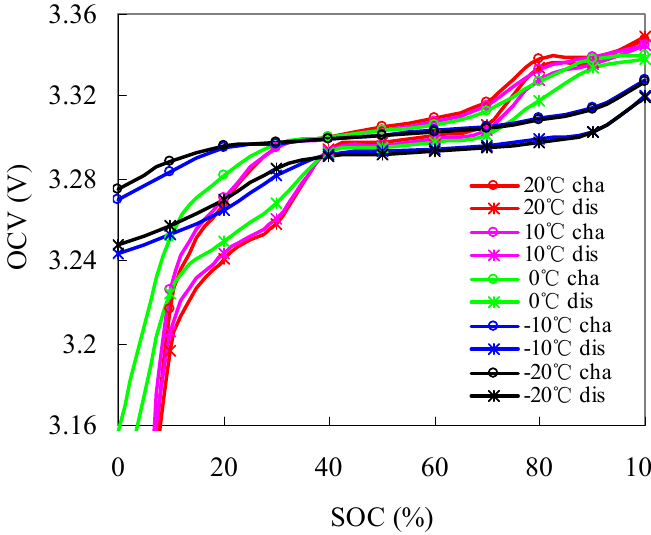
Figure 14. Charged and discharge R–L non-rated OCV–SOCs at different